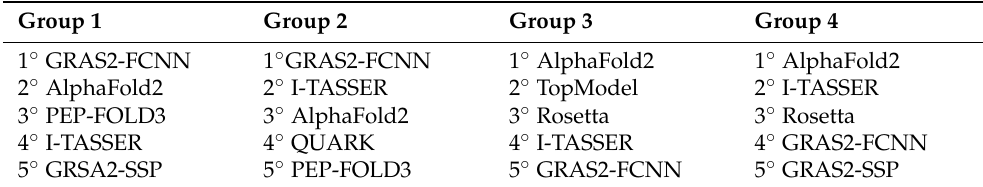
Table 2. Ranking of algorithms by TM-score.